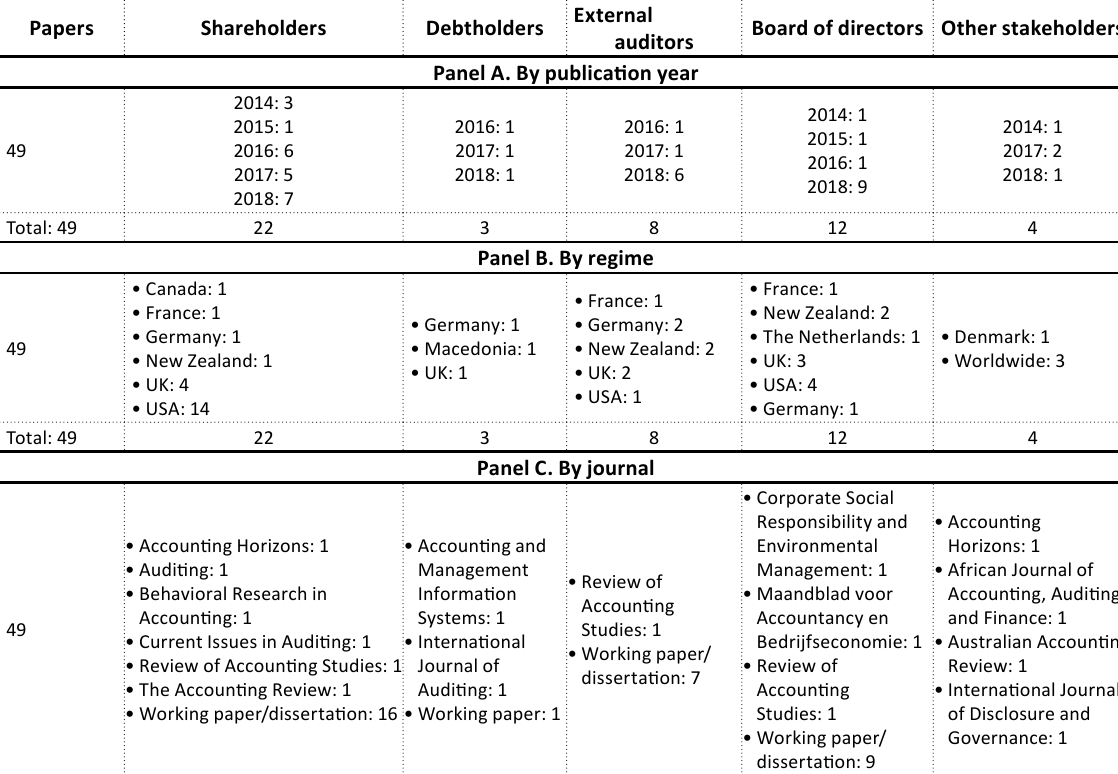
Table 2. Count of published papers cited Papers Shareholders Debtholders